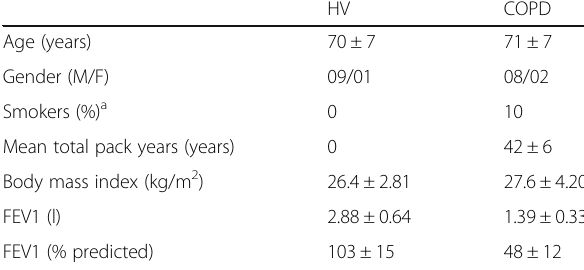
Table 1 Demographics of the HV and the COPD